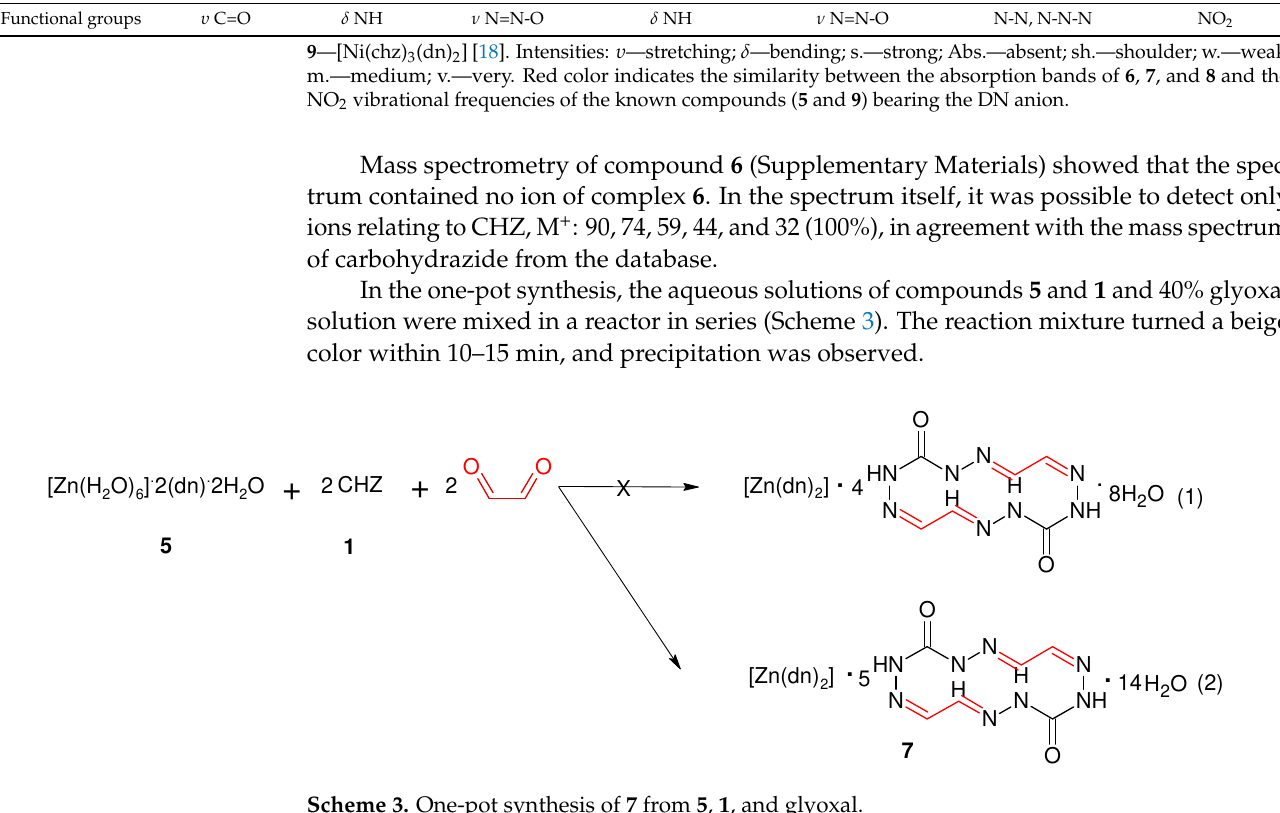
Scheme 3. One-pot synthesis of 7 from 5 , 1 , and